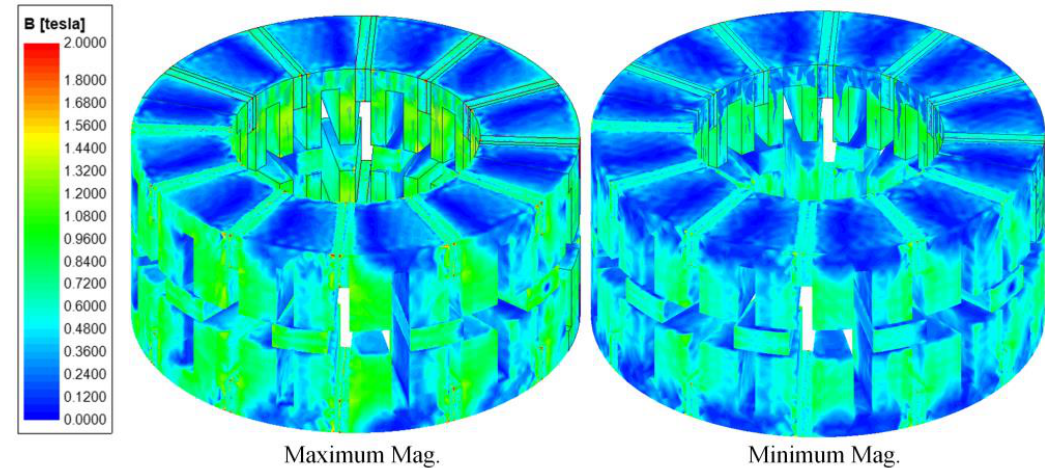
Figure 9. Flux density distribution under two typical magnetization states.